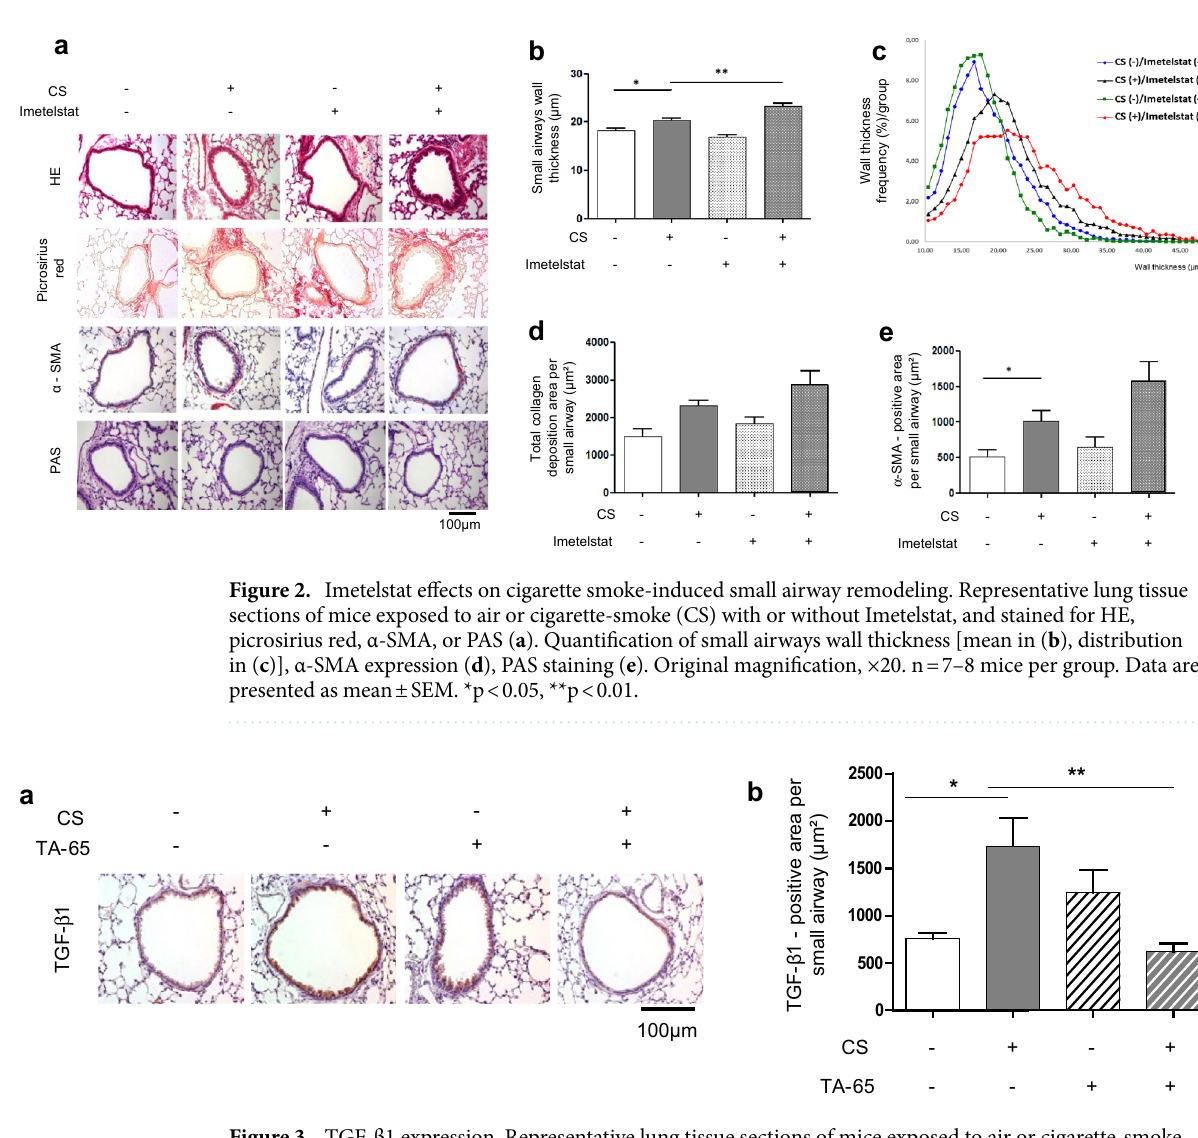
Figure 3. TGF-β1 expression. Representative lung tissue sections of mice exposed to air or cigarette-smoke (CS) ± TA-65, and subjected to TGF-β immunostaining ( a ). Quantification of TGF-β expression ( b ). Original magnification, ×20. n = 7–8 mice per group. Data are presented as mean ± SEM. *p < 0.05, **p <